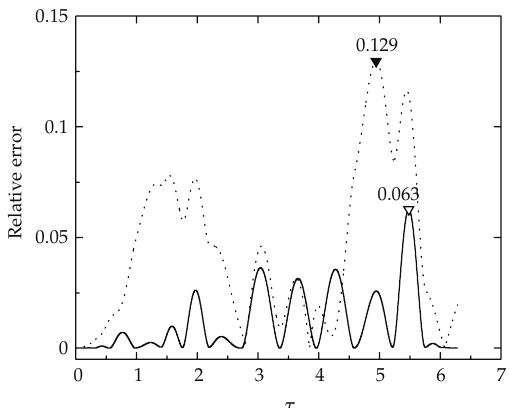
Figure 3: The relative error between HAM approximations and numerical solutions for the radius r (cid:3) τ (cid:4) (cid:3) ξ (cid:9) 1 . 063, α (cid:9) 1, θ (cid:9) 0 . 999939, h (cid:9) − 2 . 3 (cid:4) . Dotted curve: 2nd-order approximation; solid curve: 5th-order approximation.